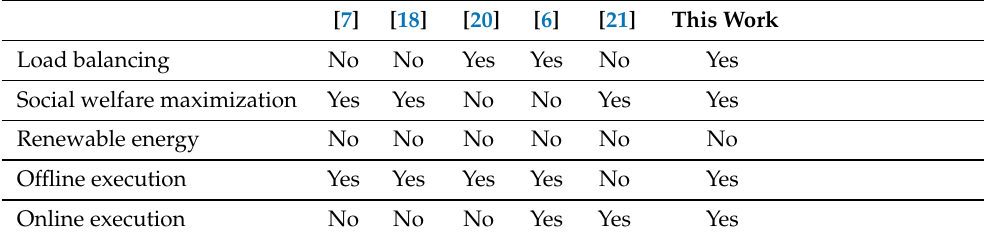
Table 1. Comparison to the state of the